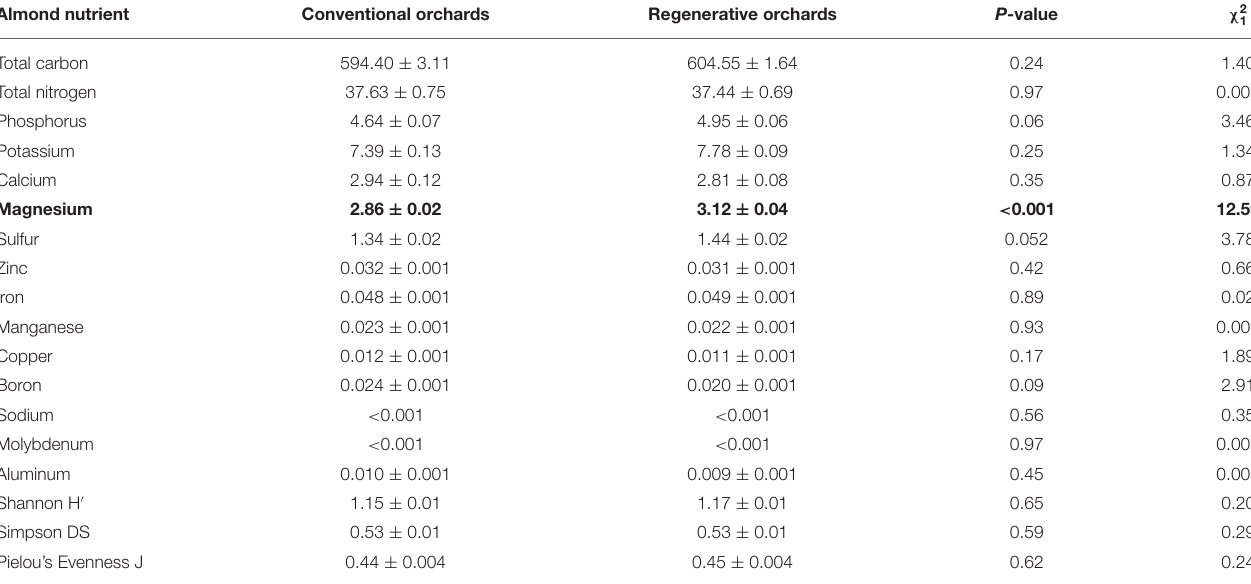
TABLE 5 | The nutrient levels in the almonds. Almond nutrient